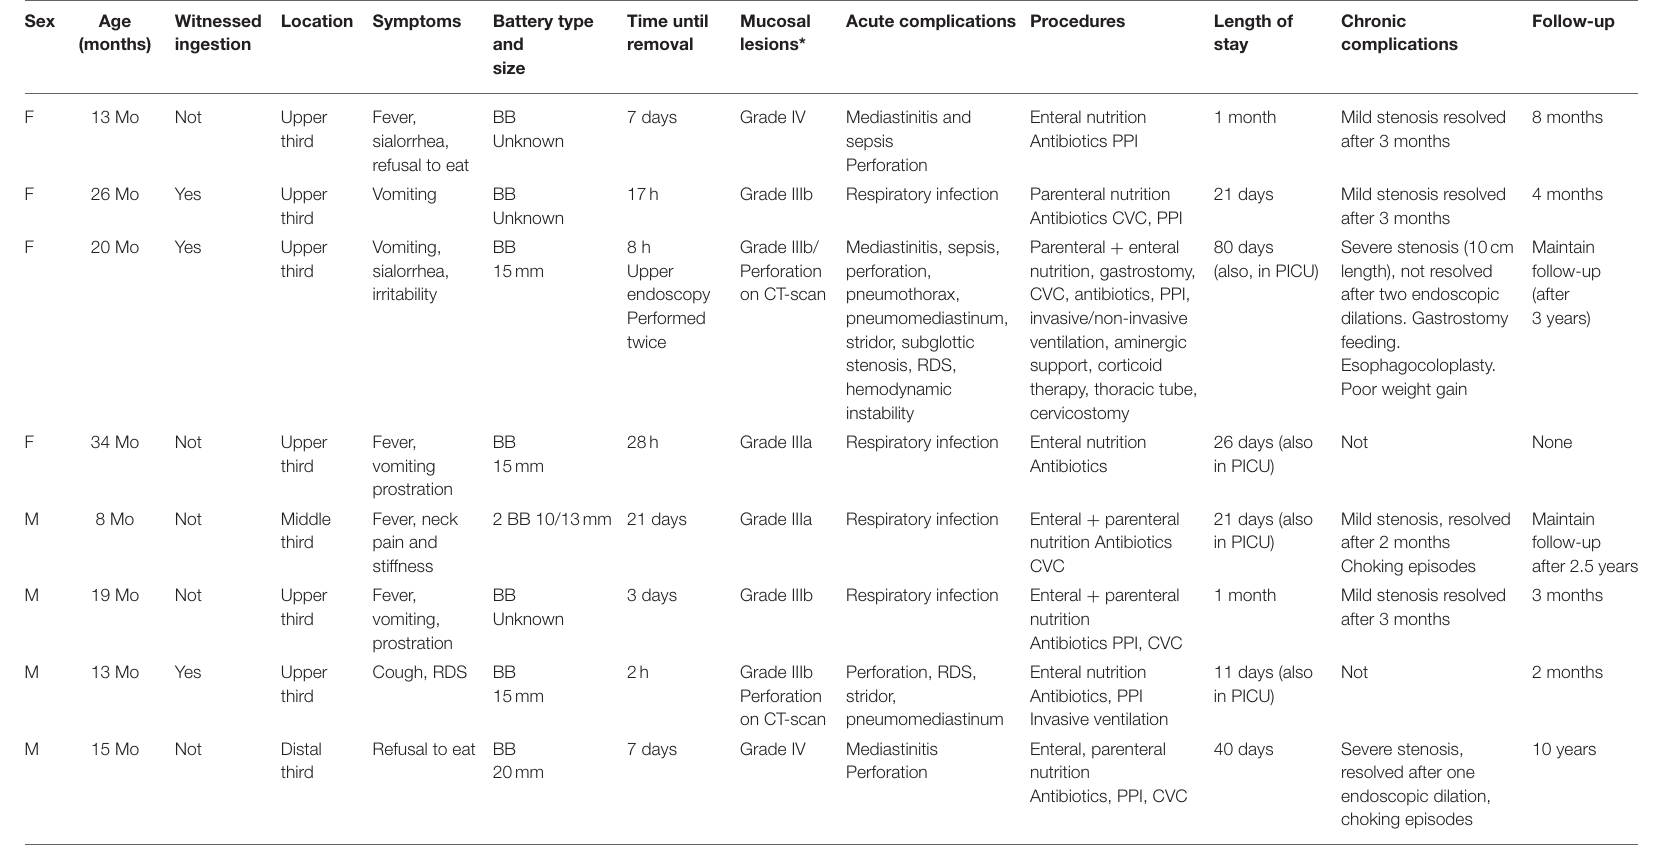
TABLE 1 | Esophageal battery ingestion-related